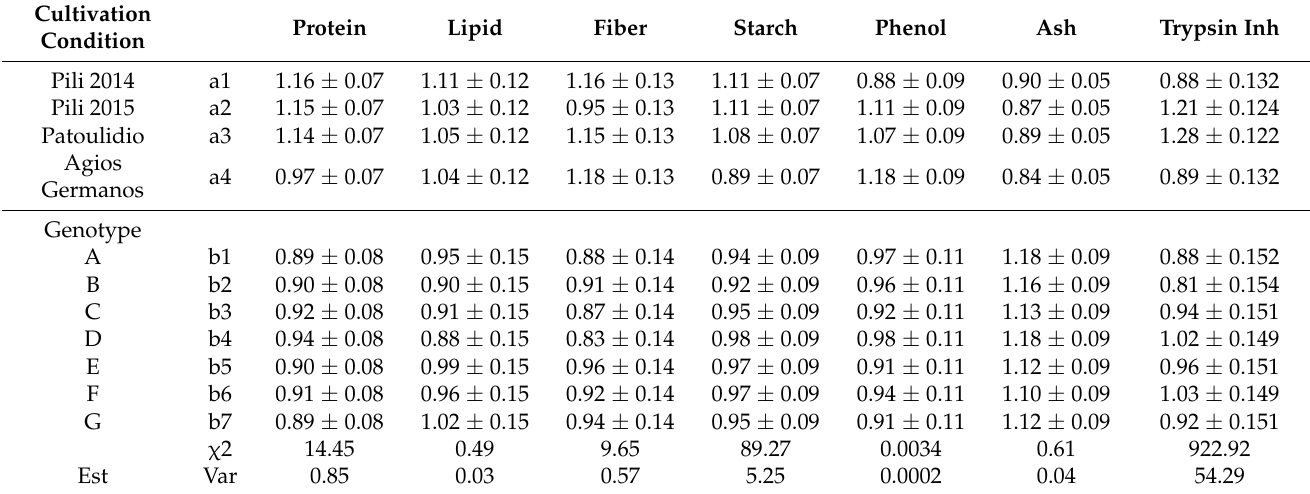
Table 7. Nutritional evaluation versus cultivation conditions based on the mathematical